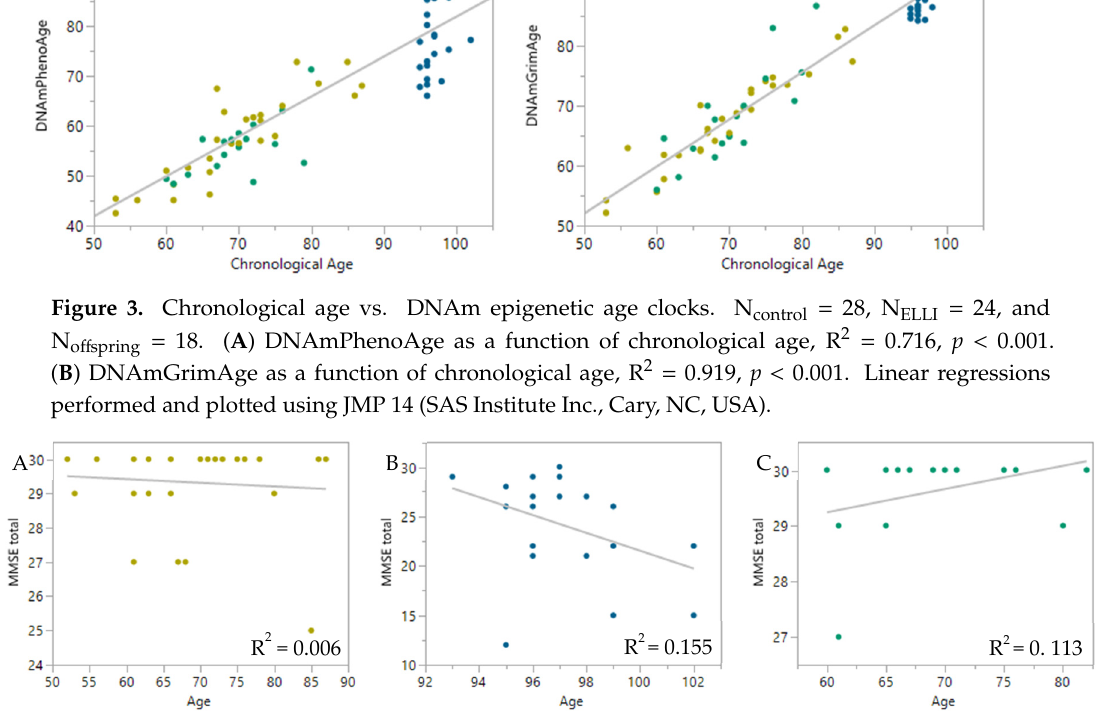
Figure 4. Cognition vs. age. Mini-Mental State Exam scores used for measuring cognitive impairment. ( A ) MMSE score of controls as a function of chronological age, N = 28, p = 0.7021. ( B ) MMSE score of ELLI as a function of chronological age, N = 21, p = 0.0776. ( C ) MMSE score of o ff spring as a function of chronological age, N = 16, p = 0.2021.